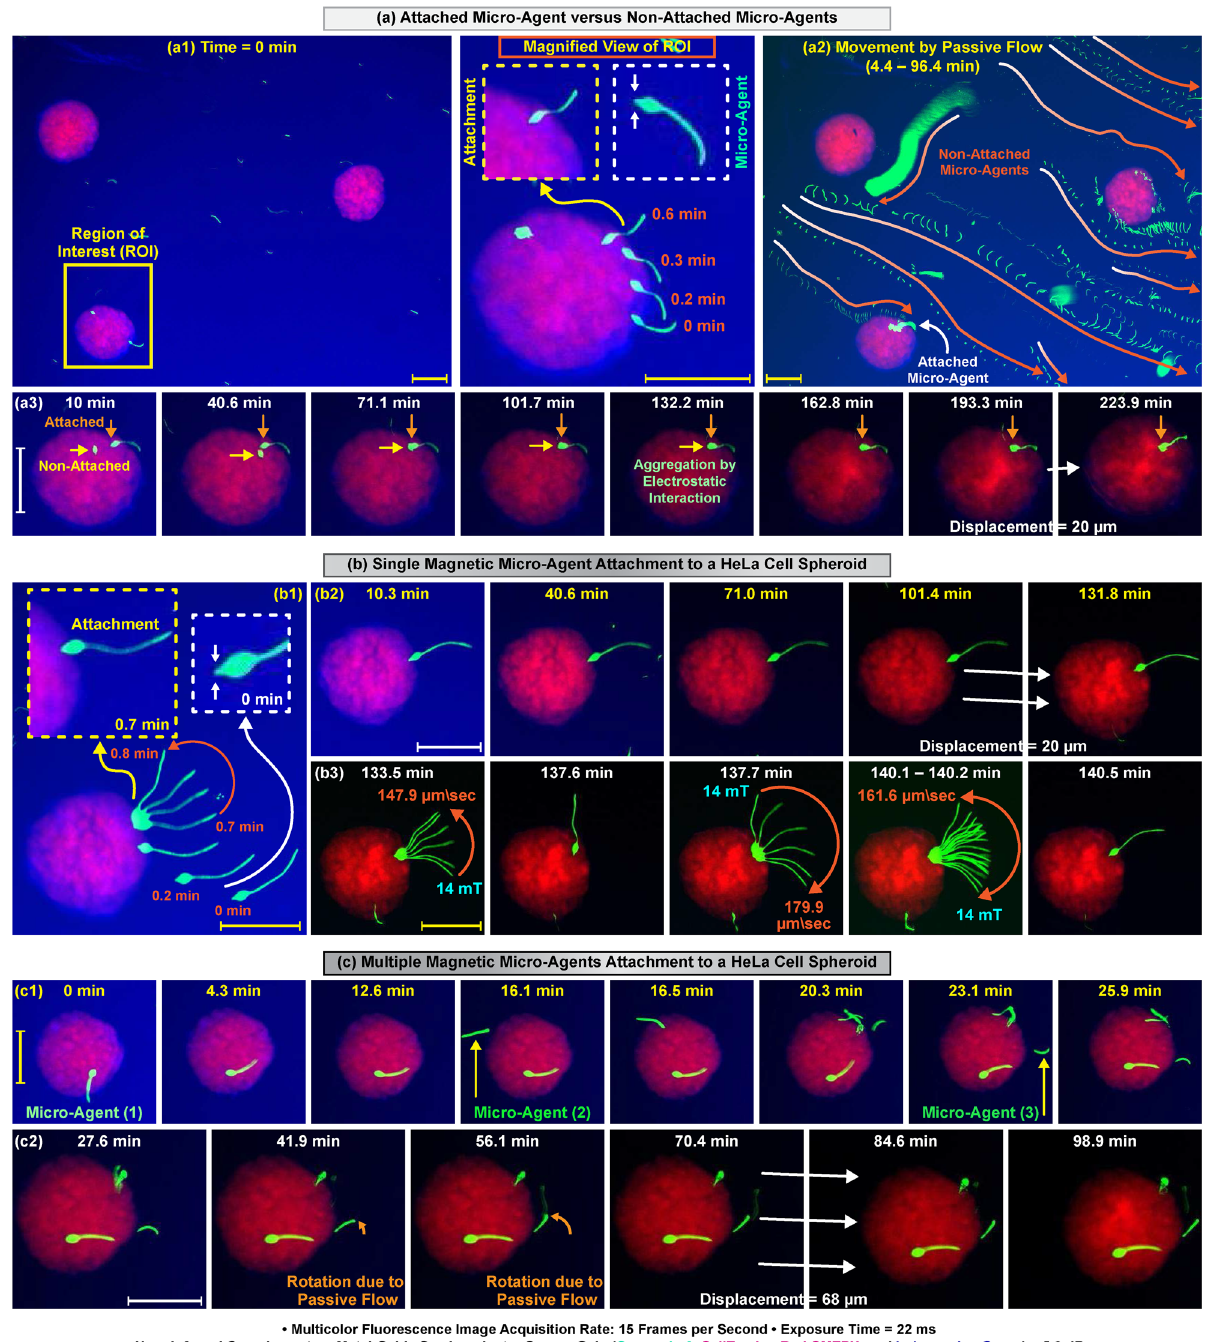
Figure 3. Time-lapse multicolor fluorescence microscopy for single and multiple magnetic micro-agents attachment to HeLa cell spheroids. ( a1 – c1 ) Attachment of micro-agents to HeLa cell spheroids with a magnetic field of 36 mT. ( a2 , a3 ) Effect of passive flow on the attached and non-attached micro-agents. ( b2 , c2 ) Visualization of the changes in the micro-agents attached to the spheroids. ( b3 ) Attachment check by rotational movement of the micro-agent around its inserted part into the spheroid after two hours pass. Scale bar 100 µ m. Please refer to the accompanying video (Part